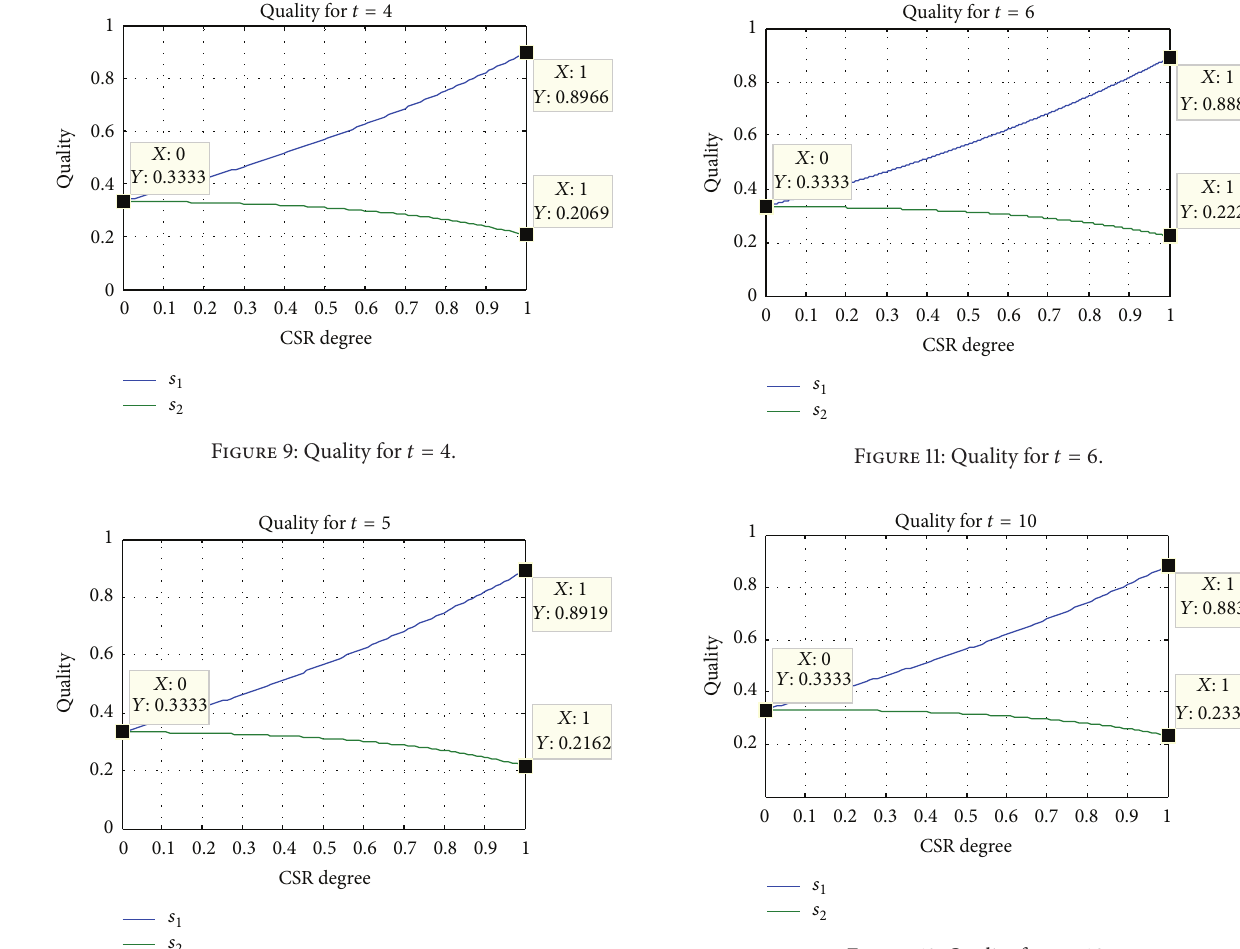
Figure 12: Quality for 𝑡 = 10 . Table 1: Social welfare and optimal CSR